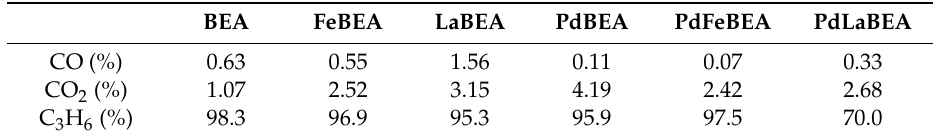
Table 2. Distribution of the C1-equivavlents that account for the C 3 H 6 desorption as well as the CO and CO 2 production during the oxidation step following the propene-TPD in Figure 1. The data is given in % distribution of how the carbon leaves the samples. BEA